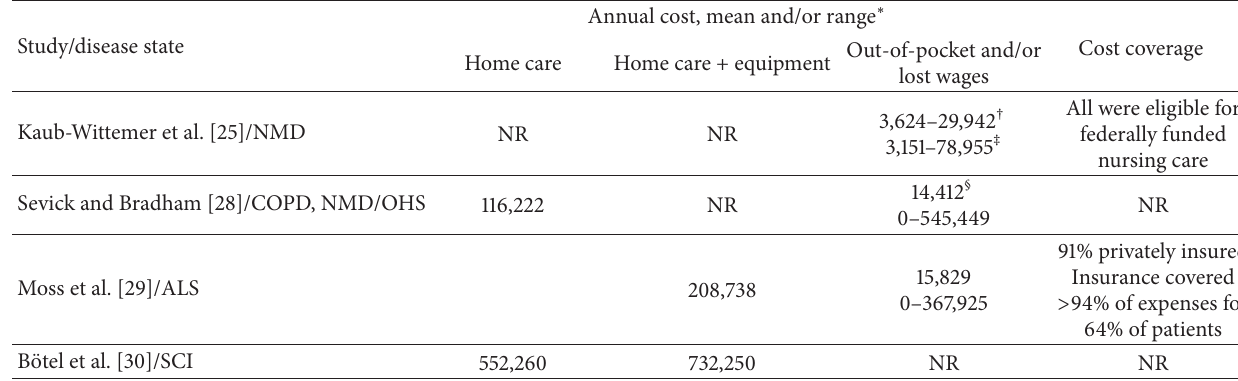
Table 6: Crude cost